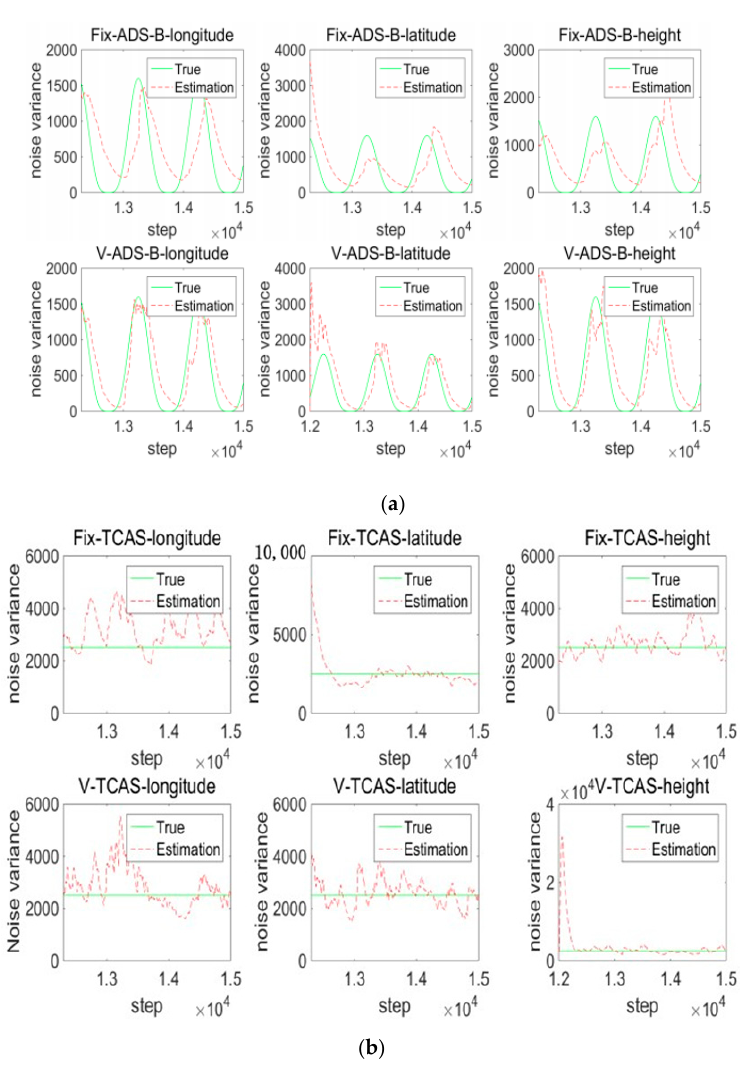
Figure 8. Noise estimation of system. ( a ) Noise estimation of ADS-B; ( b ) Noise estimation of Traffic Collision Avoidance System (TCAS).